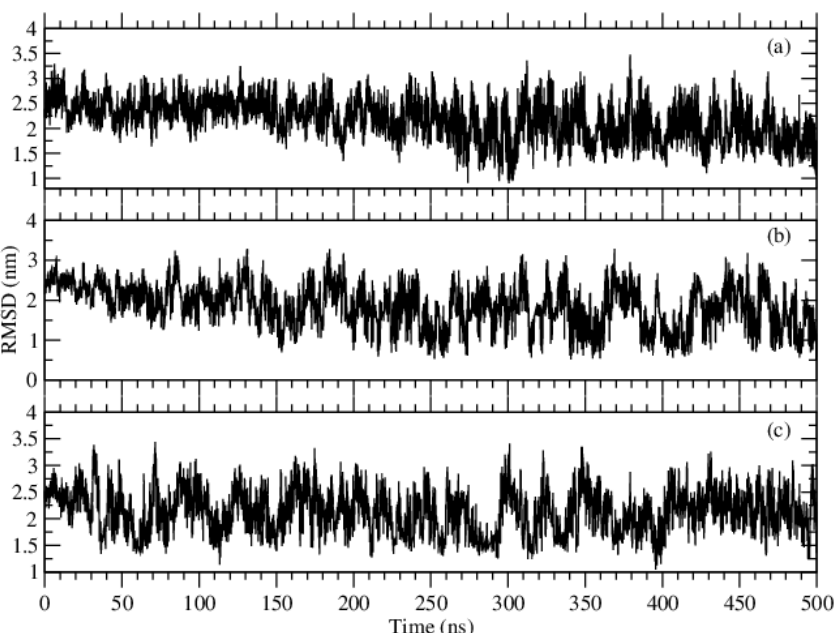
Figure 2. RMSD of the backbone atoms of the amino acids, ( a ) Phe, ( b ) Tyr and ( c ) Trp